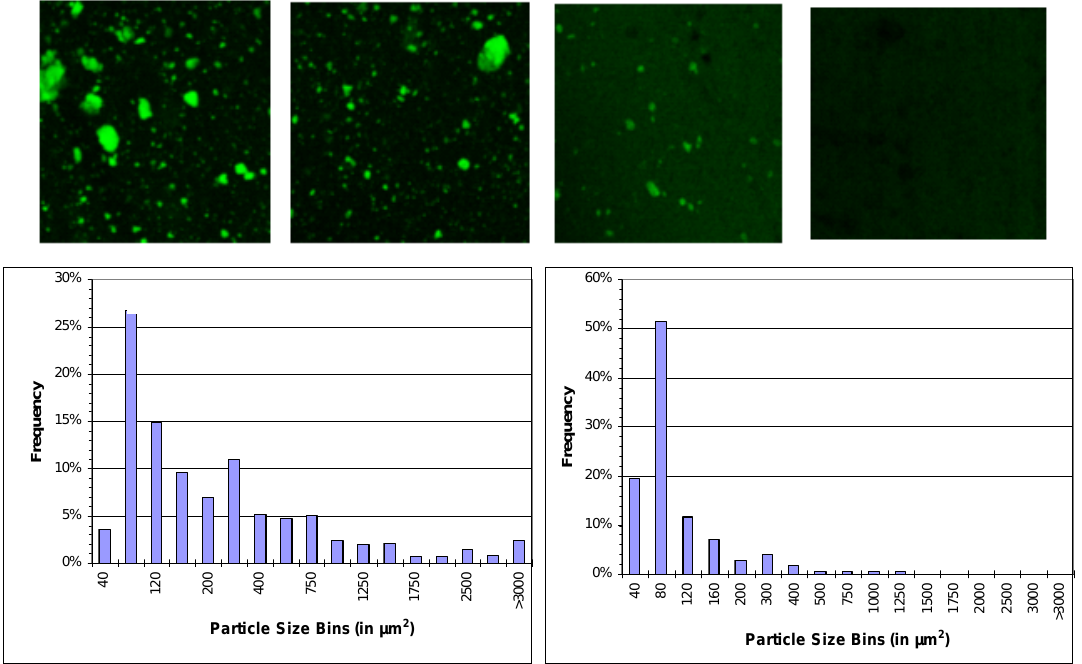
Figure 7. Confocal microscopy images of plastic containing 5% loadings of tannin esters observing the inherent autofluorescence of tannin particles distributed in the plastic (top). TanAc (left), TanPr, TanBu and TanHex (right, with each image 500 × 500 μ m). Representative particle size distributions of tannin esters in PLA. TanAc (bottom, left) and TanBu (bottom,